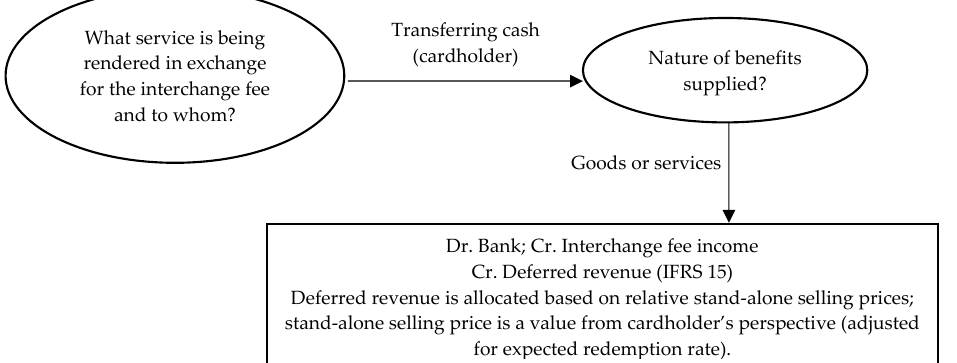
Figure 9. Identifying the cardholder as card issuer’s customer and the nature of benefits is goods and services.